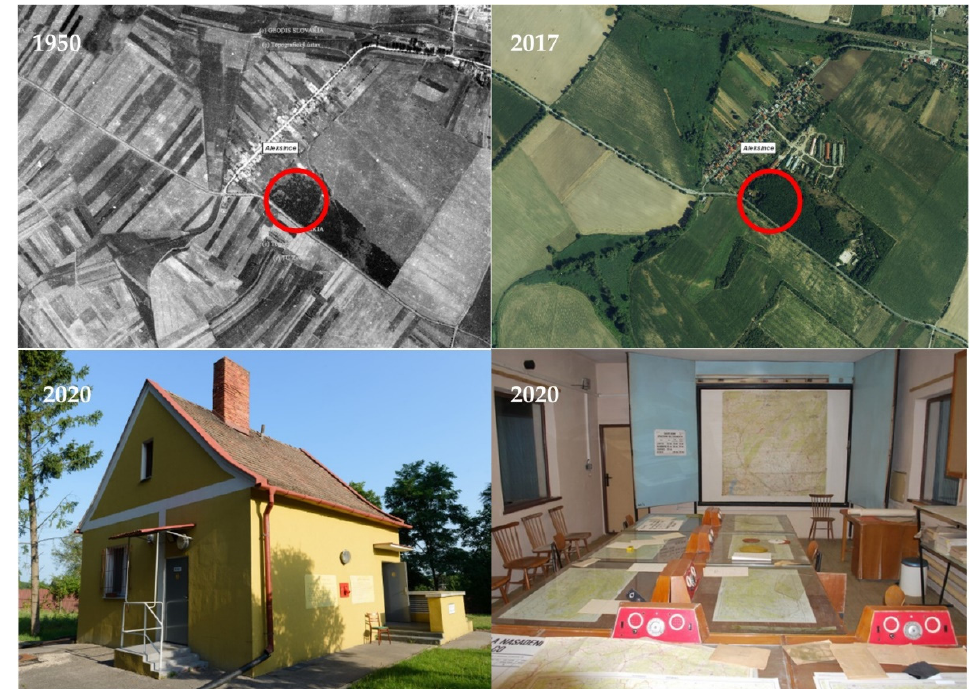
Figure 4. Visual interpretation of the Alekšince (Museum of Socialism and the Cold War) site. Source: 1950—Adapted with permission from ref. [37]. Copyright 2021 GEODIS SLOVAKIA, s.r.o. Bratislava, Topografický ústav Banská Bystrica. 2017—Adapted with permission from ref. [38]. Copyright 2021 GKÚ Bratislava, NLC Zvolen. 2020 left—Reprinted with permission from ref. [47]. Copyright 2021 Dromedar.sk. 2020 right—Reprinted with permission from ref. [48]. Copyright 2019 Miribord. It is unique in Slovakia, as the museum is located at a depth of 7 m